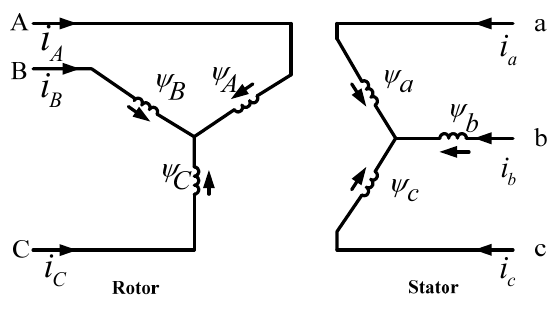
Figure 2. Equivalent circuit of the equivalent machine component.